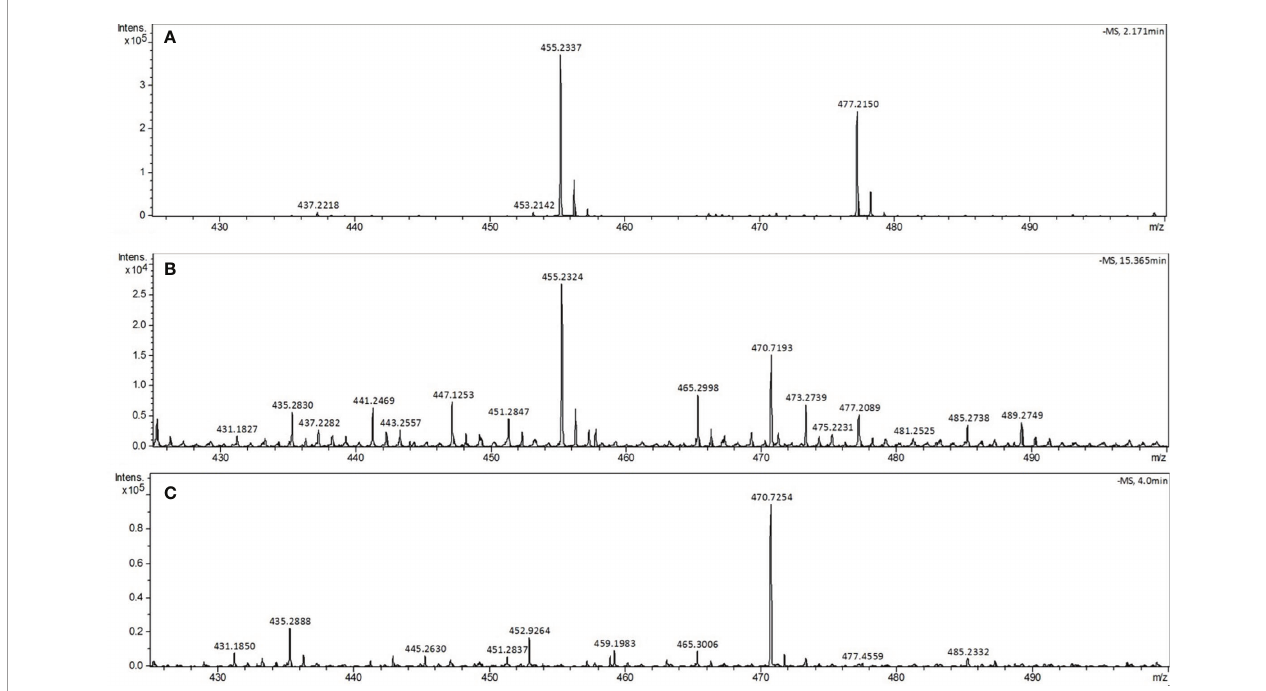
FIGURE 6 | Analysis of phytyl-PP by LC-MS system II. The phytyl-PP spectra were obtained from TLC bands recovered from the samples with the same R f as the phytyl-PP standard. (A) Phytyl-PP standard, (B) infected erythrocytes and (C) uninfected erythrocytes. Ions: [M] - m/z 455.2337 and [M + Na] - m/z 477.2150. The experiment was performed twice with similar results.